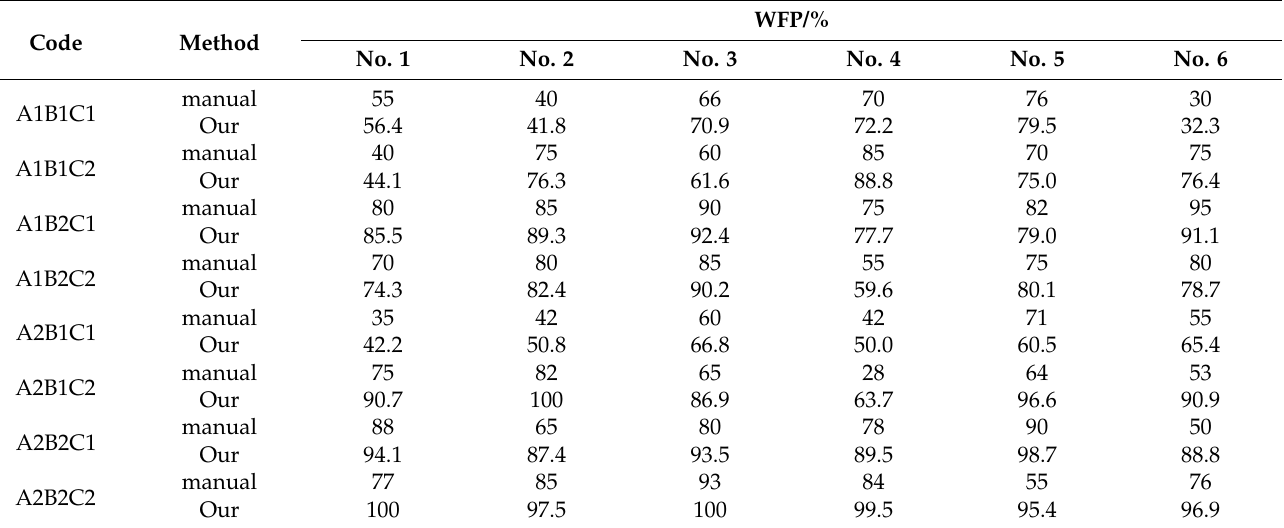
Table 5. WFP measurement results.